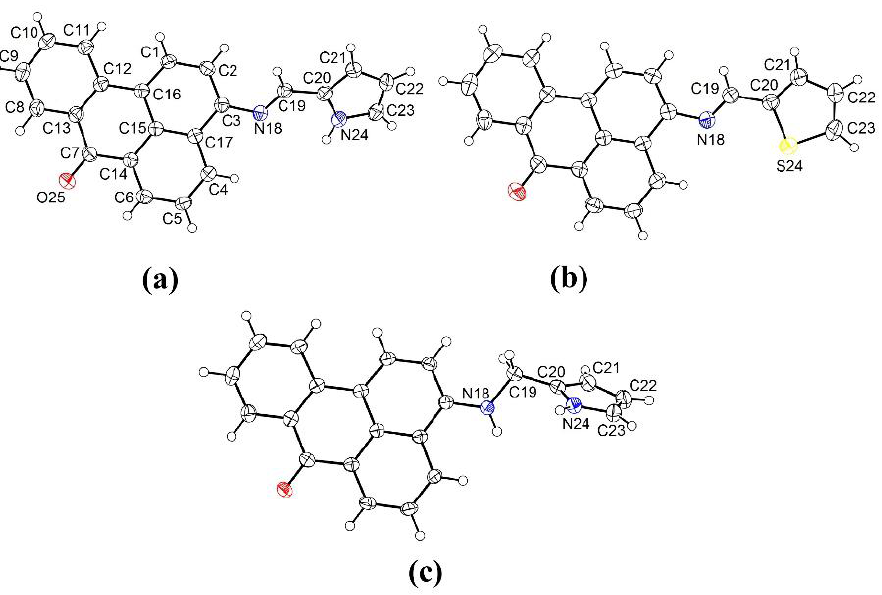
Figure 3. ORTEP diagram of molecules 2a ( a ), 2e ( b ), and 3a ( c ). Atomic numbering scheme of the benzanthrone systems in 2e and 3a corresponds to one in 2a . Table 1. Several geometrical parameters (Å, ◦ ) for molecules 2a , 2e , and 3a . Bond,